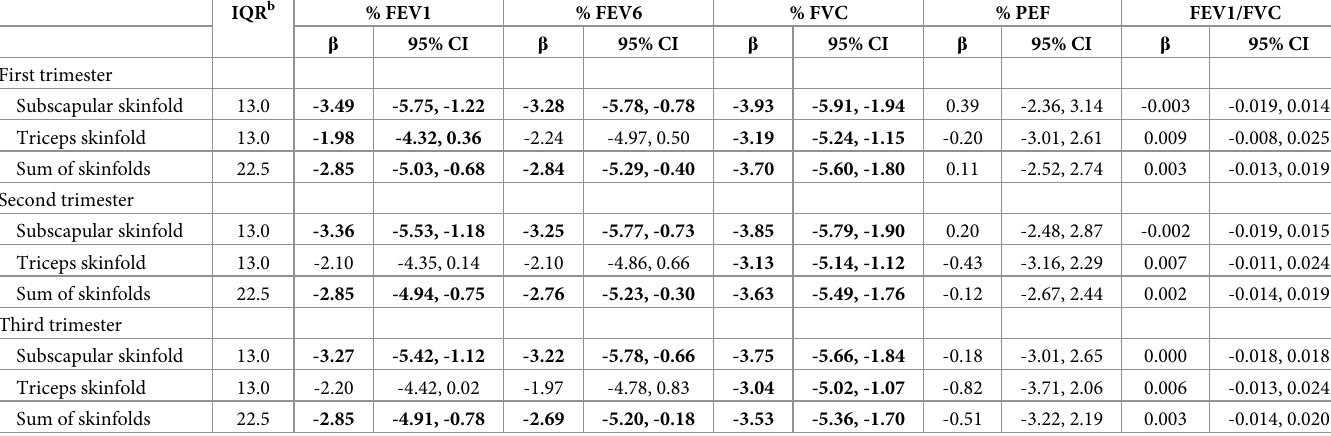
Table 1. Adjusted a association for an IQR-increase in maternal body composition associated with lung function in the Breathe-Wellbeing, Environment, Lifestyle, and Lung Function Study, 2015–2019,